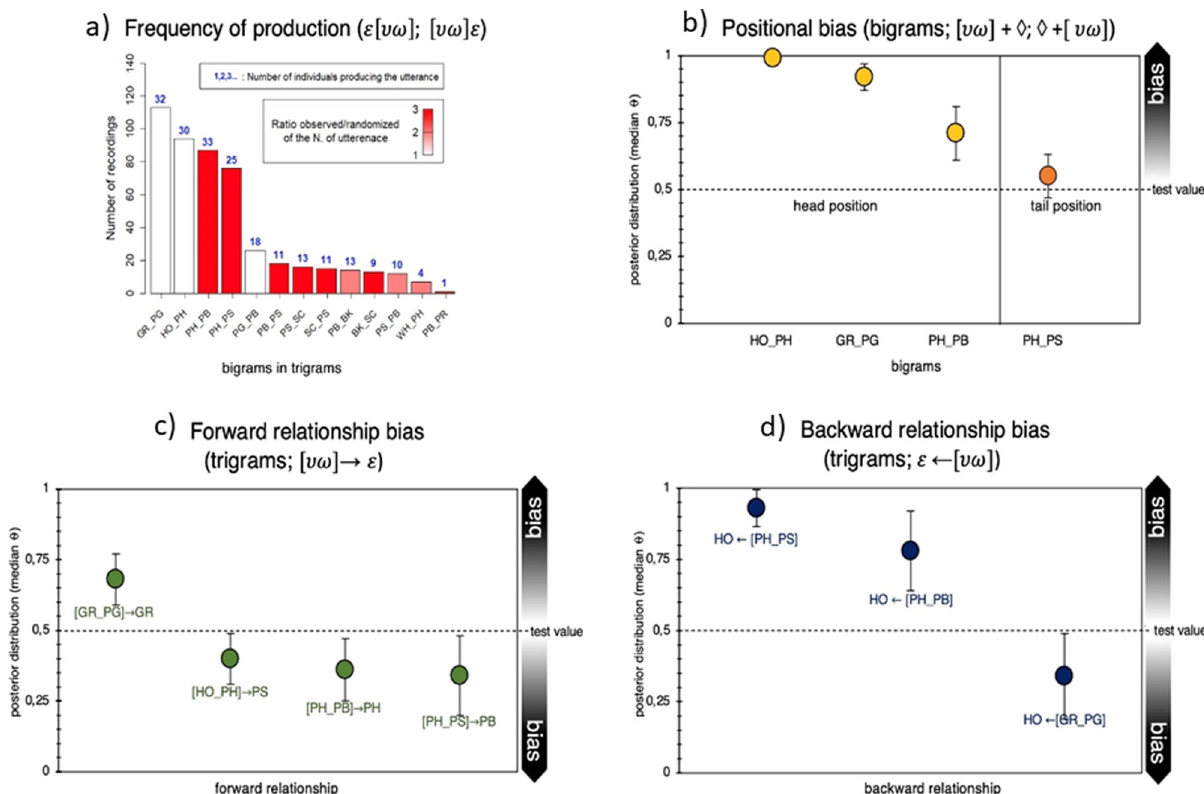
Fig. 4 Speci fi c ordering frequency, positional bias, and relationship bias for trigrams. a Bigrams in trigrams that were produced above chance (i.e., >95% more likely than by random juxtaposition of single units). The height of each bar corresponds to the number of times each utterance was recorded. The color gradient in the bars depicts the number of times each utterance was observed divided by the number of times each utterance was present on average in each randomization (averaged over 1000 randomizations). The color ranges from the lowest ratio in white (i.e., the utterance was present in the observed data two times more than in the randomization) to the highest ratio in red (i.e., the utterance was present in the observed data 13 times more than in the randomized data). The number on top of each bar in blue indicates the number of individuals that produced each utterance. b Likelihood for a certain bigram υω to occur in head position (yellow) or in tail position (red) in trigrams, expressed as median posterior distribution ( θ ). Bars stand for Credible Intervals (CI) at 95%. ♢ = irrespective of unit type (see Table 4). c Likelihood for a certain bigrams ð υω Þ to be in a forward relationship (green) with a certain ð ε Þ single unit following it (see Table 4). d Likelihood for a certain bigram ð υω Þ to be in a backward relationship (blue) with a certain ð ε Þ single unit following it (see Table 4). *The bigram PB_PR appeared in the dataset only 1 time and it appeared 250 times less in the randomizations as compared to the observed frequency (i.e., it appeared only 22 times in 1000 randomization so at an average frequency of 0.022), and not 3 times as indicated by the red color. We used a gradient of color from 1 to 3 to visualize the variation in the other bigrams bearing in mind that the ratio observed/randomized of the last bigram (PB_PR) is much higher than indicated in the fi